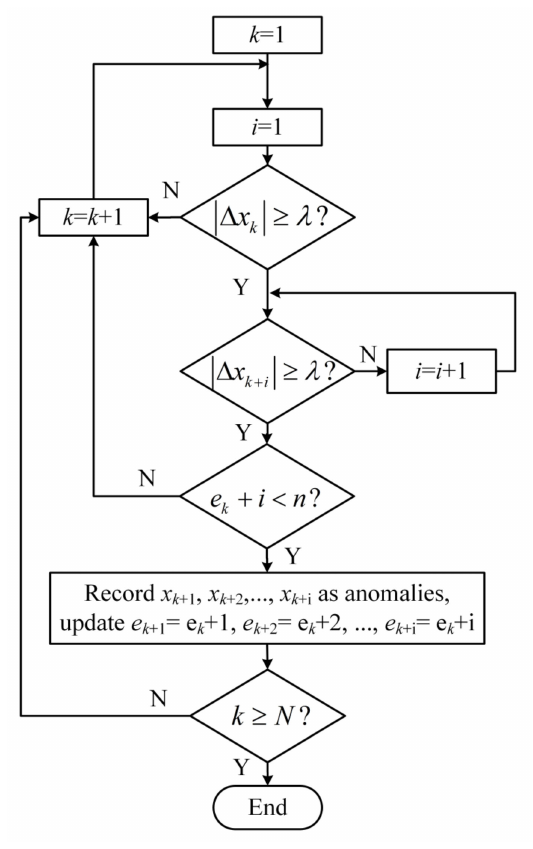
Figure 7. Abnormal overrun data detection.